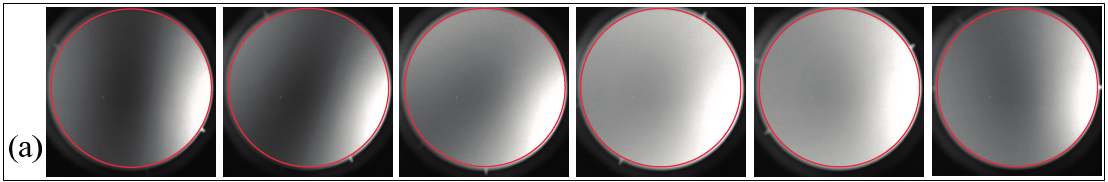
Figure 8. ( a ) Images of the sky with polarizer at 0 , 30 , 60 , 90 ,120 ,150 